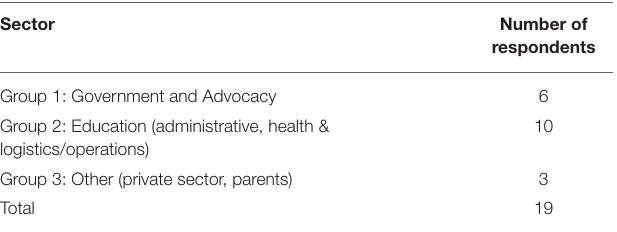
TABLE 2 | Menstrual equity policy in NYC school